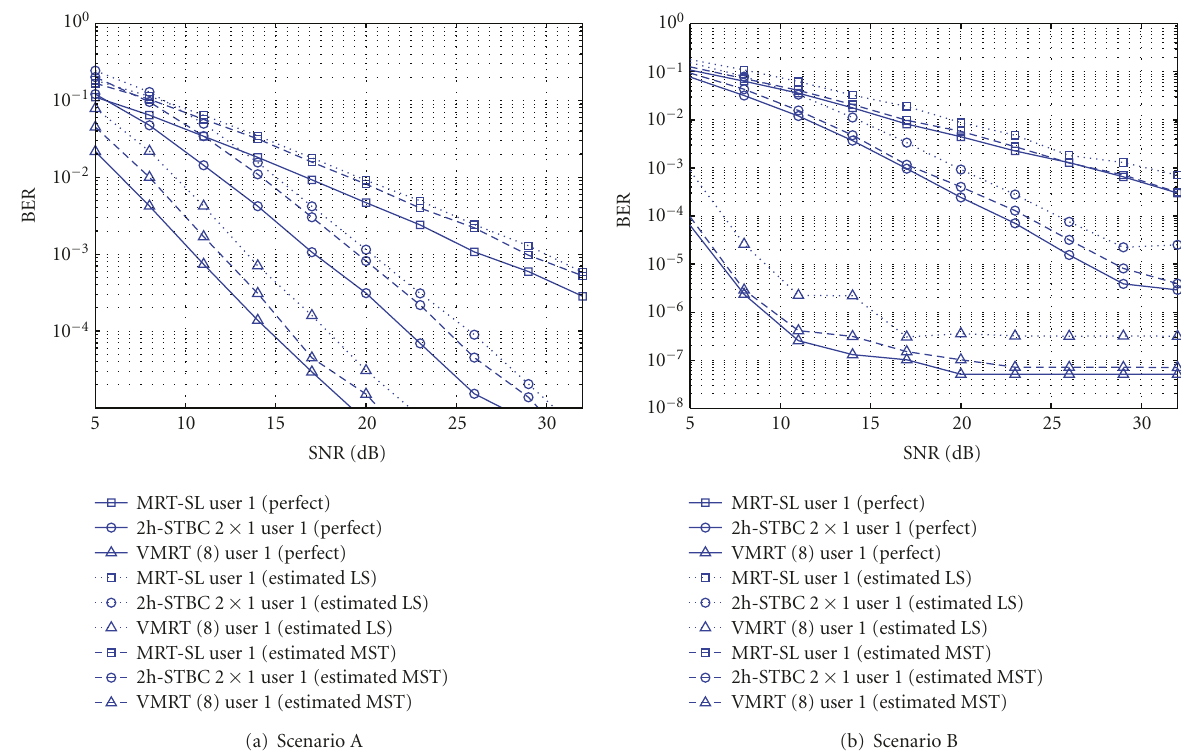
Figure 2: E ff ect of channel estimation: uncoded QPSK, SUI-3 channel; N t = 4, N RS = 8, N VMRT = 8, N u =